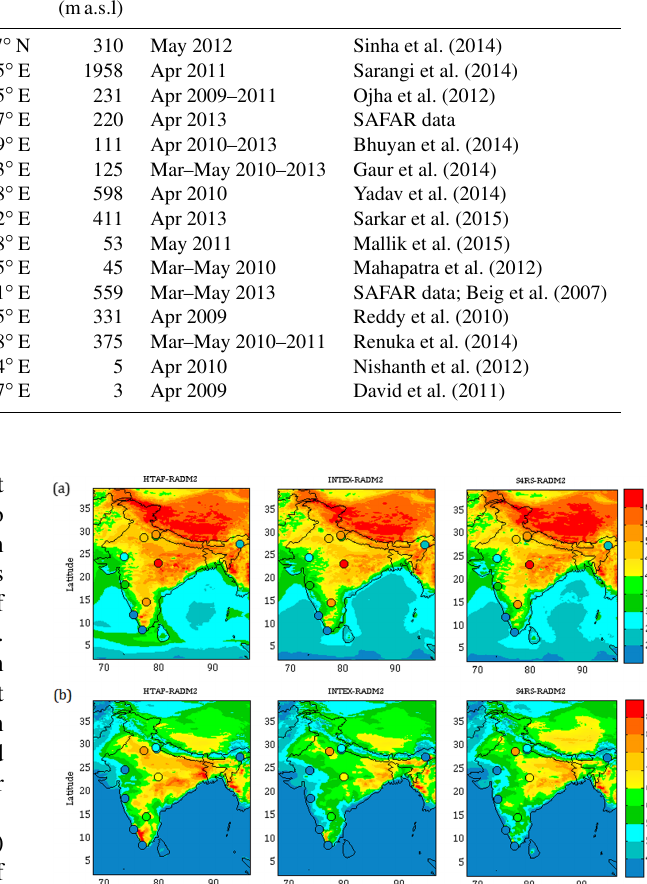
IGP for the INTEX-B and SEAC4RS inventories. Differ- ences are also found over the southern Indian region with stronger ozone production in HTAP, followed by INTEX-B and